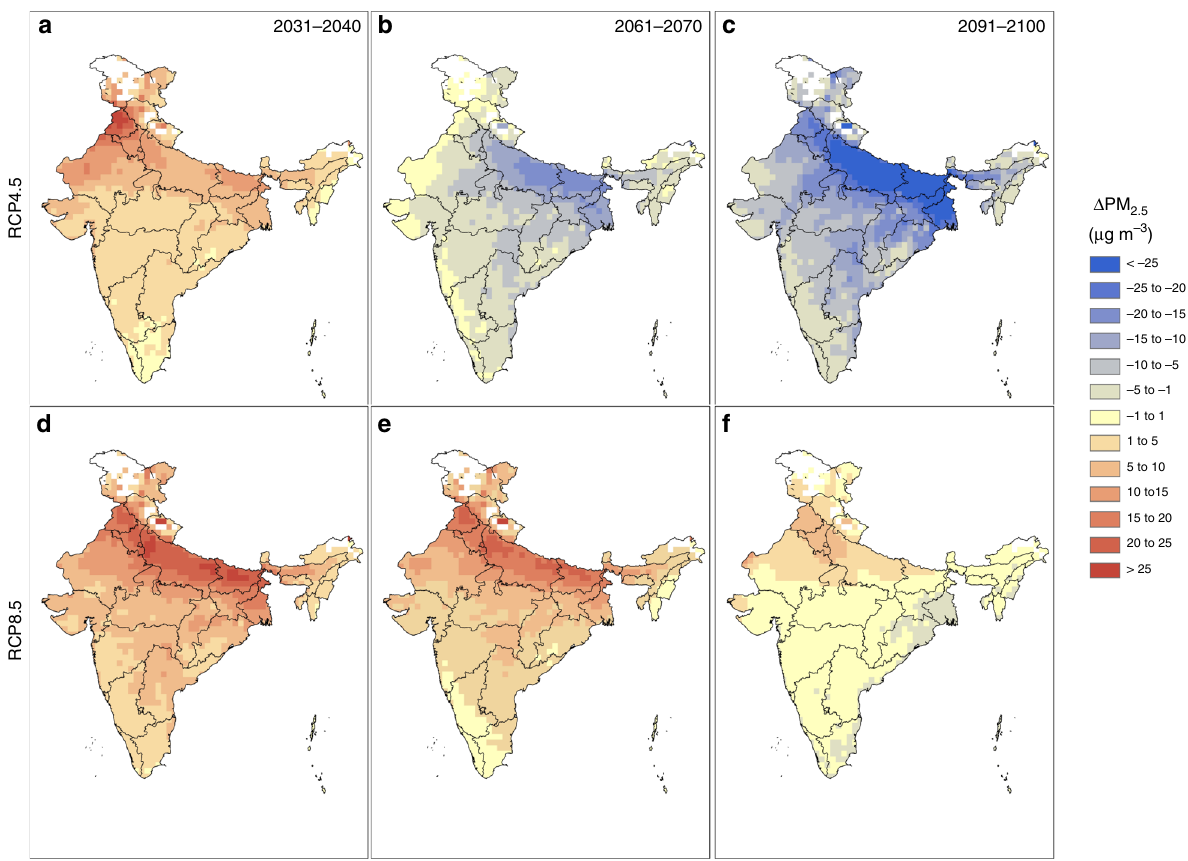
Fig. 2 Projected spatial distribution of change in ambient PM 2.5 exposure with respect to baseline period over the Indian landmass. Spatial distribution of the projected changes in PM 2.5 exposure ( Δ PM 2.5 ) from the baseline (2001 – 2005) exposure under RCP4.5 for a near future (2031 – 2040), b distant future (2061 – 2070) and c far future (2091 – 2100) and under RCP8.5 scenario 5 for d near future (2031 – 2040), e distant future (2061 – 2070) and f far future (2091 – 2100) Reddish (bluish) tinge signi fi es projected increase (decrease) in PM 2.5 in